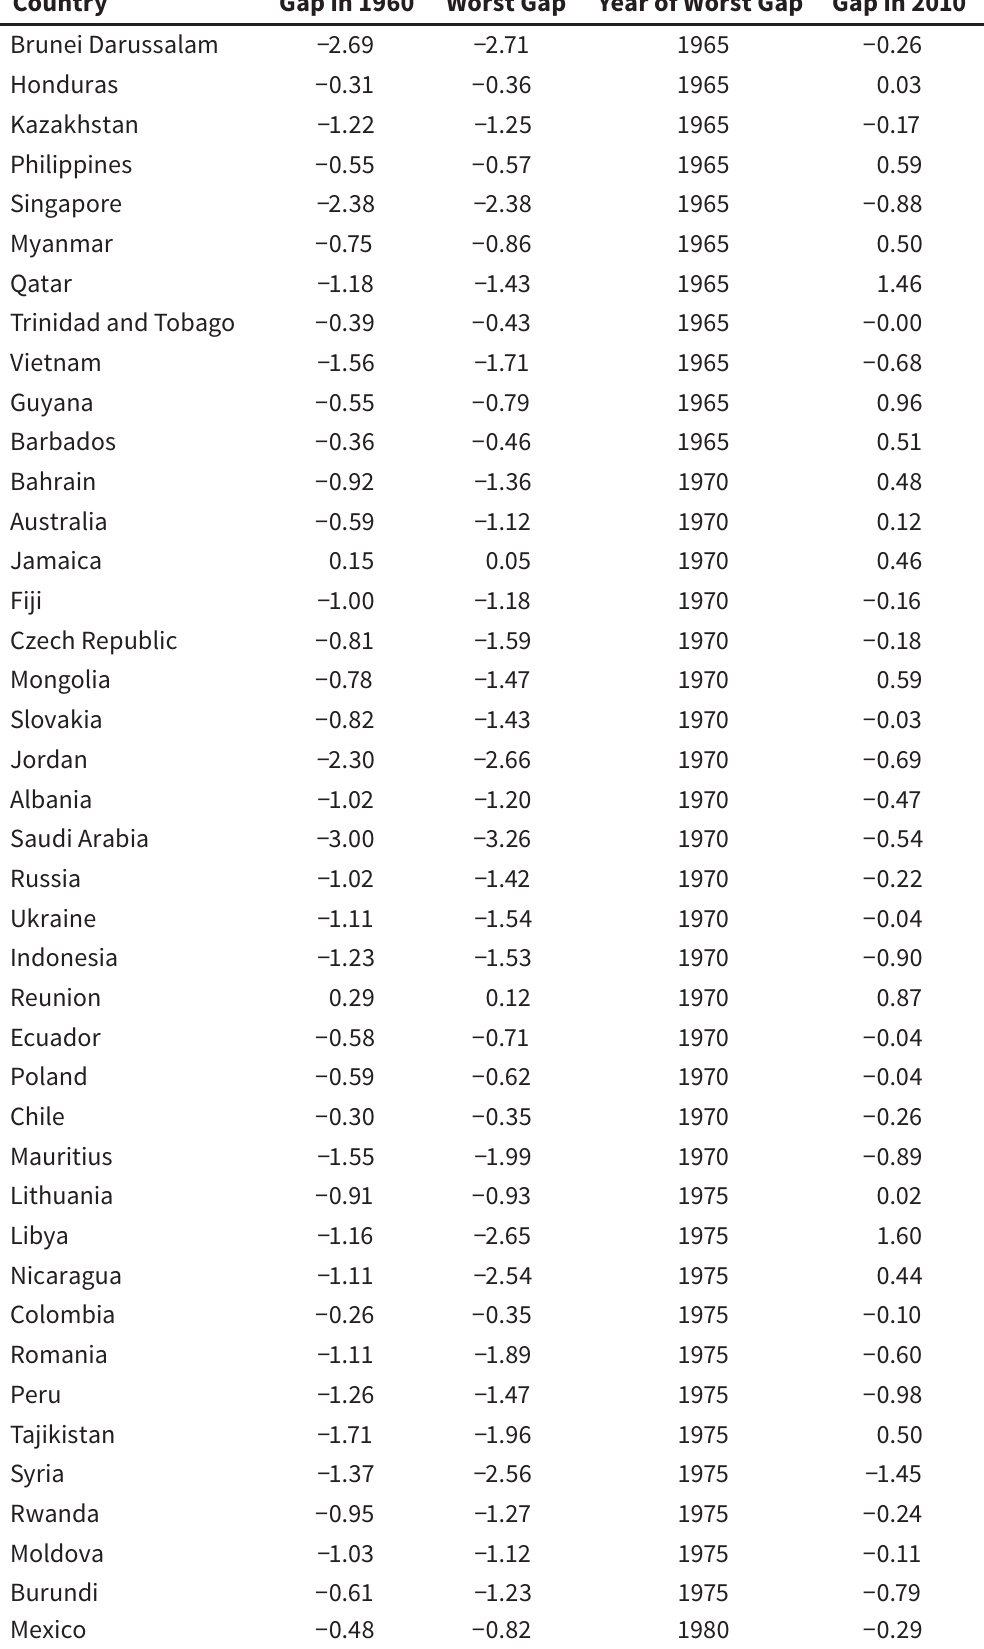
Countries Where The Gender Gap Got Worse Before It Got